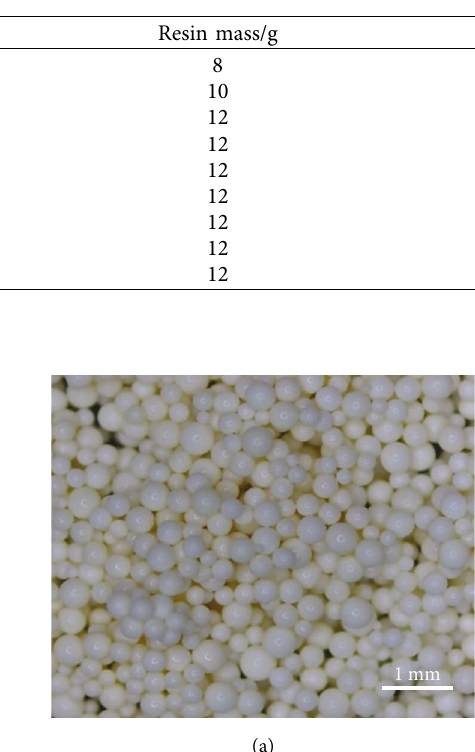
Table 1: Different enrichment conditions.